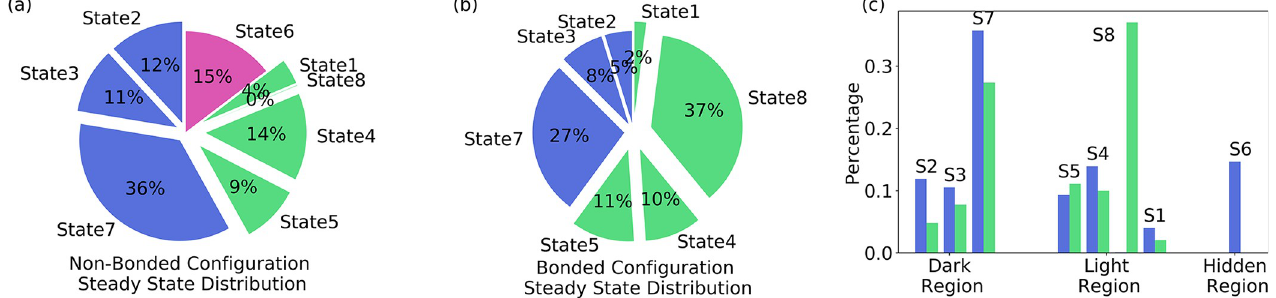
Fig 5. The estimated steady state distributions for each state based on Markov state model. (a) Steady state distribution based on non-bonded configuration simulations; (b) Steady state distribution based on bonded configuration simulations; (c) Steady state distribution differences between non-bonded and bonded configurations. States 2, 3, and 7 are considered as dark states region. States 1, 4, 5, and 8 are considered as light state region. State 6 is considered as hidden region.